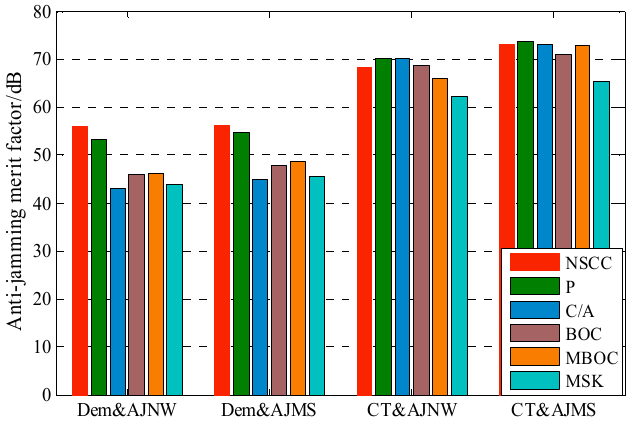
Figure 8. The comparison of anti-jamming merit factor for 20 MHz pre-filtering bandwidth.